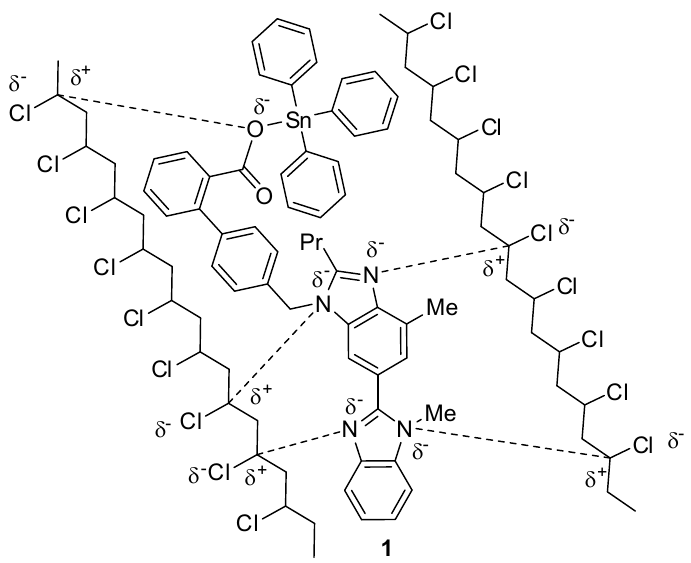
Figure 18. Organotin 1 acts as a primary photostabilizer.